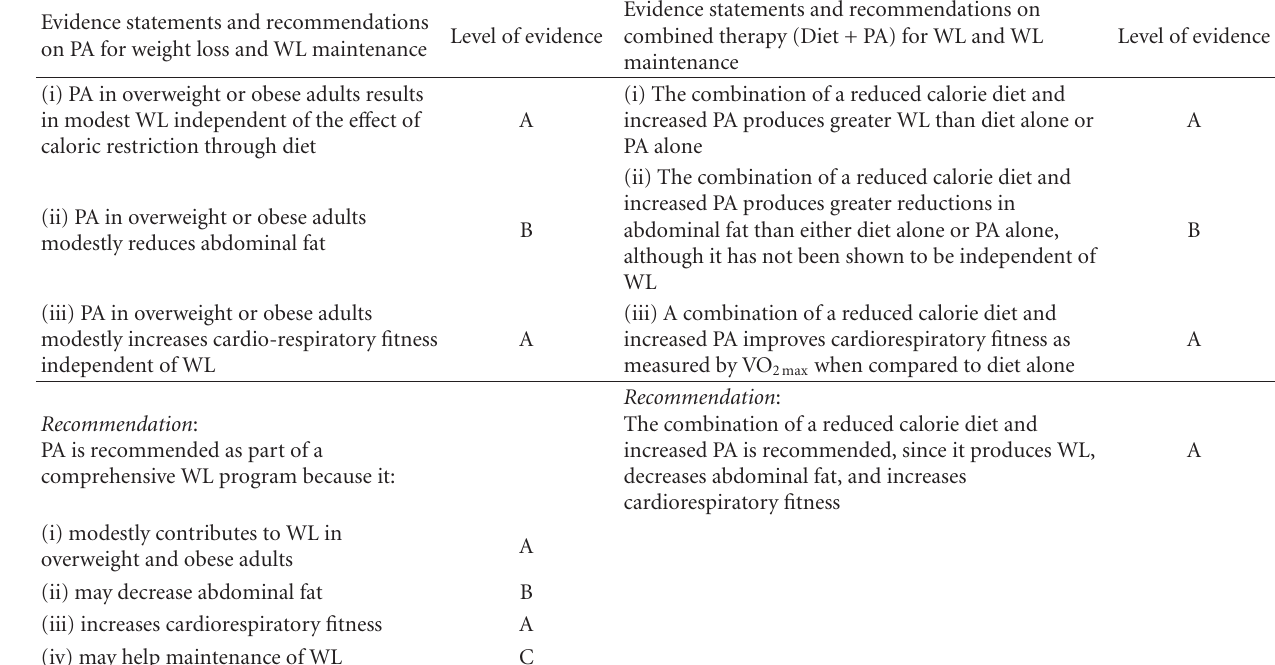
Table 1: Recommendations for physical activity in the management of obesity